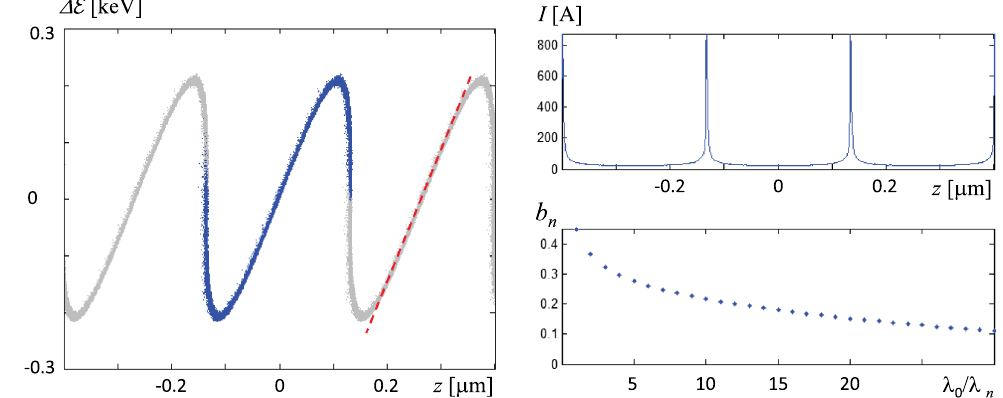
FIG. 13. Application B: longitudinal phase space, current and bunching after 1st chicane.